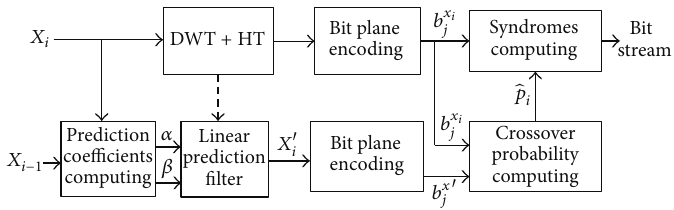
Figure 4: The encoding process of SW-BPE.